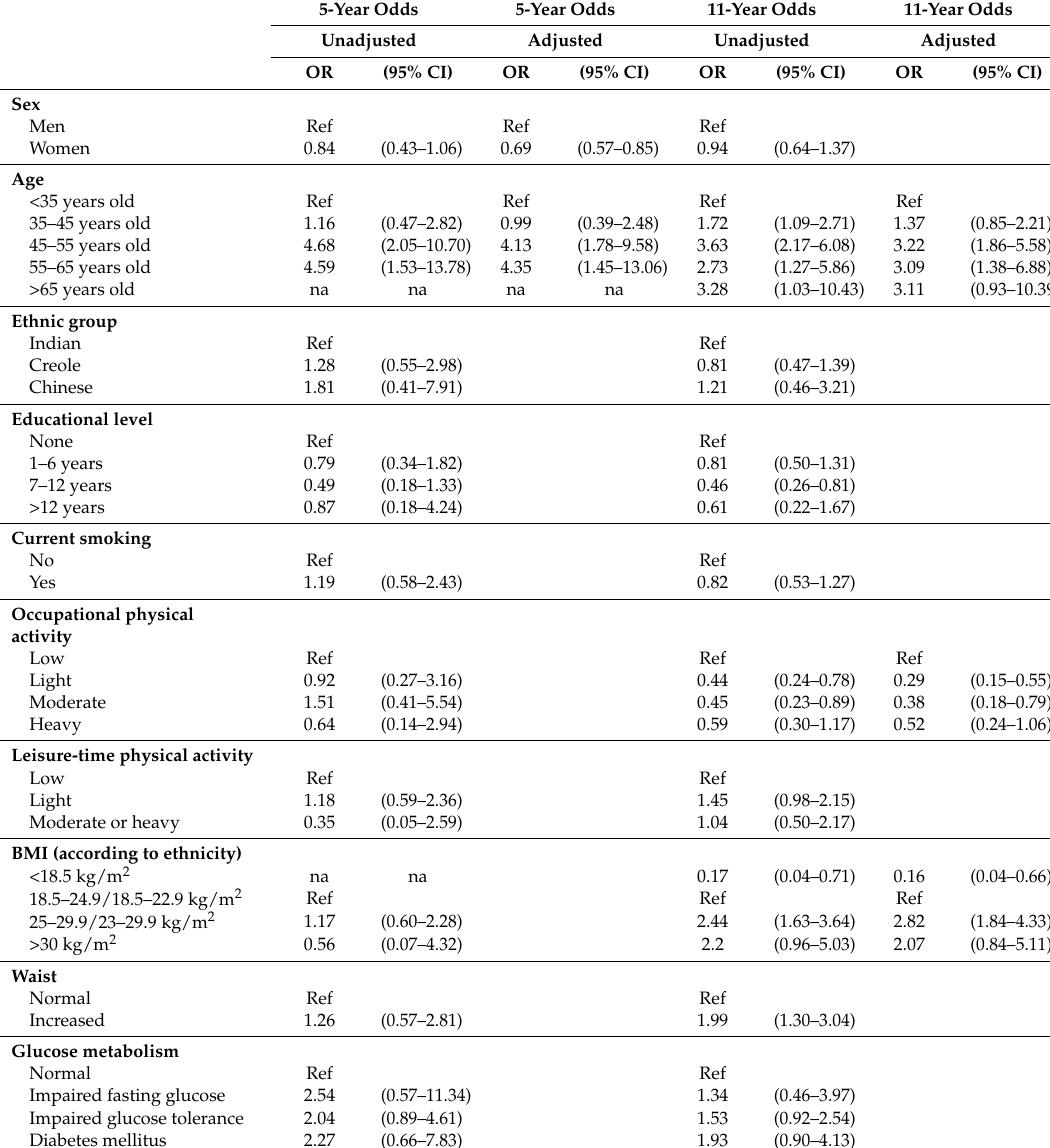
Table 2. Predictors of 5- and 11-year risk of hypertension in normotensive people at baseline in Mauritius in